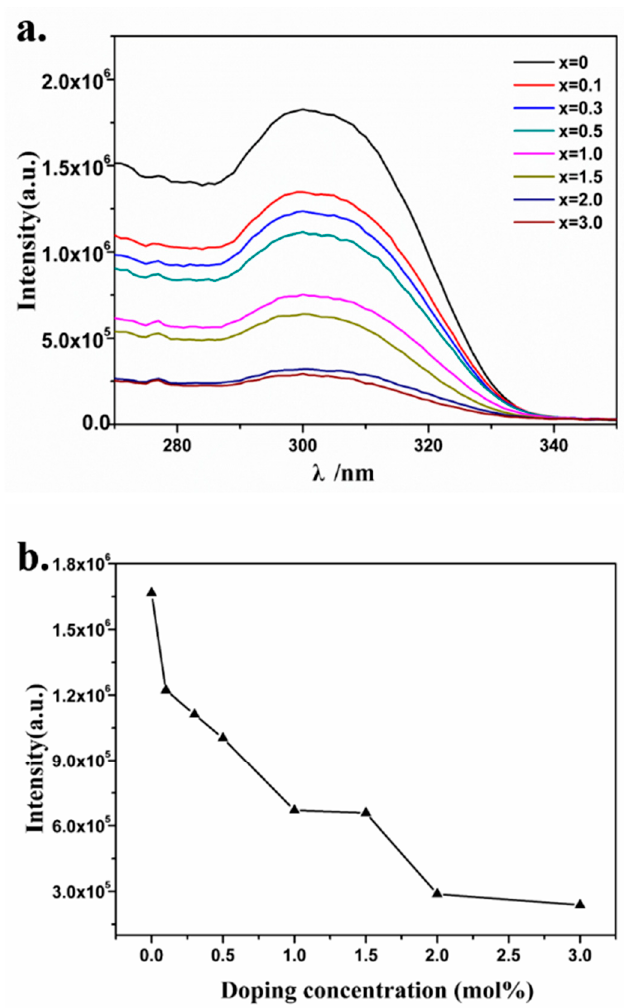
Figure 4. ( a ) The photoluminescence excitation spectra ( λ em = 499 nm) of Sr 2 Ca (1 − 1.5x%) WO 6 : x mol%Dy 3+ (x = 0, 0.1, 0.3, 0.5, 1.0, 1.5, 2.0, 3.0). ( b ) The concentration-dependent excitation intensity variation of phosphors at 310